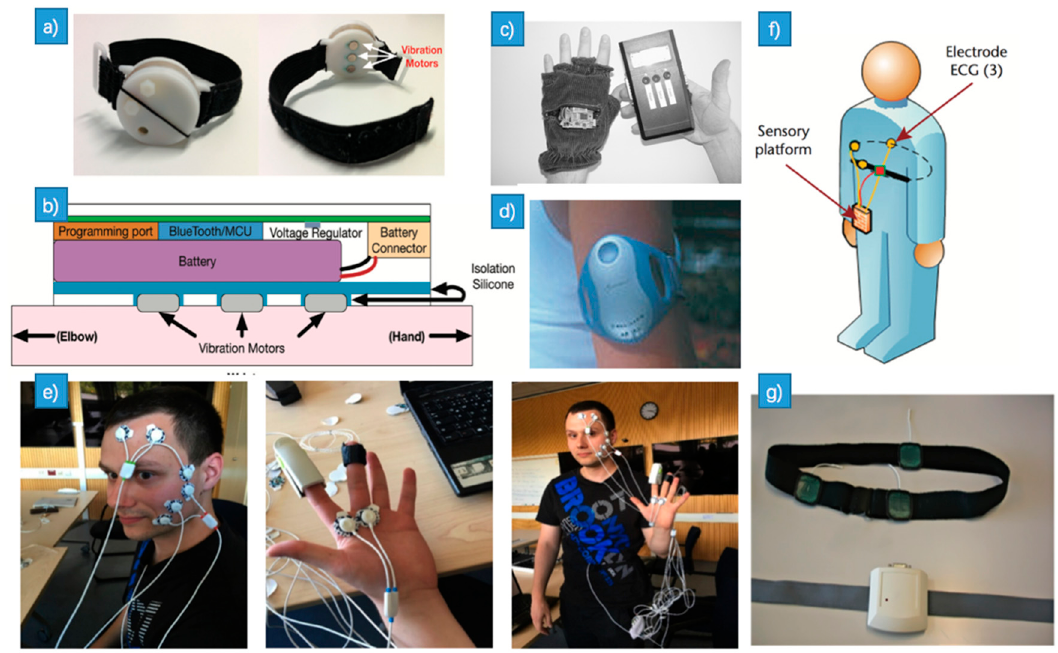
Figure 8. ( a ) The Emotion Check device; ( b ) Diagram describing the components of the Emotion Check device; ( c ) Prototype of glove with sensor unit; ( d ) Body Media Sense Wear Armband; ( e ) Left: The physiological measures of EMG and EDA. Middle: The physiological measures of EEG, BVP, and TMP. Right: The physiological measures of physiological sensors in the experiments; ( g ) Illustration of R-TIPS. This platform allows wireless monitoring of cardiac signals. It consists of a transmitter system and three sensors; ( f ) The transmitter system is placed on the participant’s hip, and the sensors are placed below right breast, on the right side, and on the back.